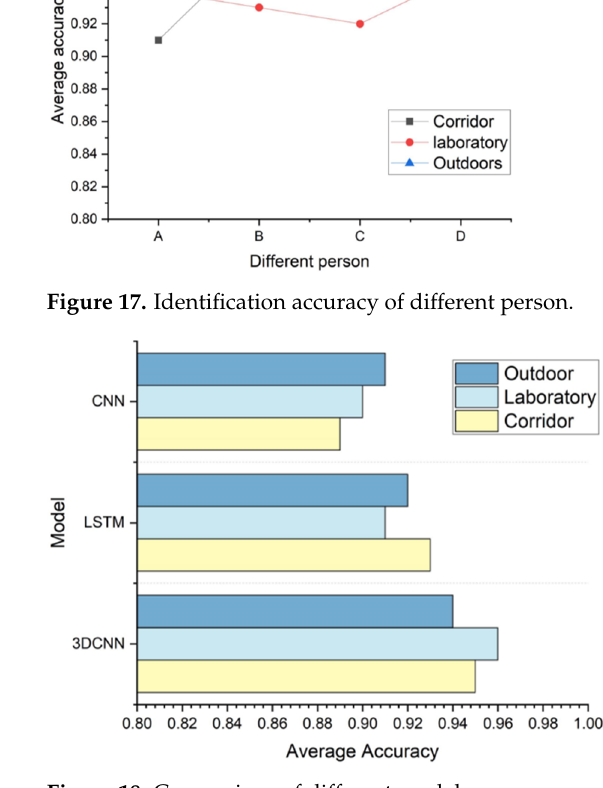
Figure 20. Characteristic comparison diagram. 4.2.9. Comparison with Previous Studies Previous studies very similar to those mentioned in the article mainly include Tao et al. [25] used the Dual-Channel CNN to train and classify the data. Yong et al. [27] used the End-To-End multi-dimensional CNN training data. Zhaoyang et al. [28] used the mix- ing CNN to train recognition on the concatenated gesture feature set. Jing Biao [29] used the one-dimensional V3 structure and LSTM fusion network for gesture recognition on raw echo data. Tao et al. [25] used range and doppler features to describe gestures. So the description of motions is not comprehensive, and the average recognition rate of gestures is 75%. Yong et al. [27] used the end-to-end CNN to train and recognize gestures on a three-dimensional gesture feature set. The average recognition rate for motions is 78%. Zhaoyang et al. [28] concatenate distance, doppler, and angle features. The average recog- nition rate is 80%. Jing Biao [29] used the one-dimensional V3 structure and LSTM fusion network to process raw echo data. Since the raw data is not preprocessed, the average recognition rate is only 72%. The three-dimensional CNN trains a three-dimensional ges- ture feature set. The gesture feature set describes gestures comprehensively and accu- rately. Therefore, the average recognition efficiency is high, reaching 83%. The compari- son of the recognition effect is shown in Figure 21 below.